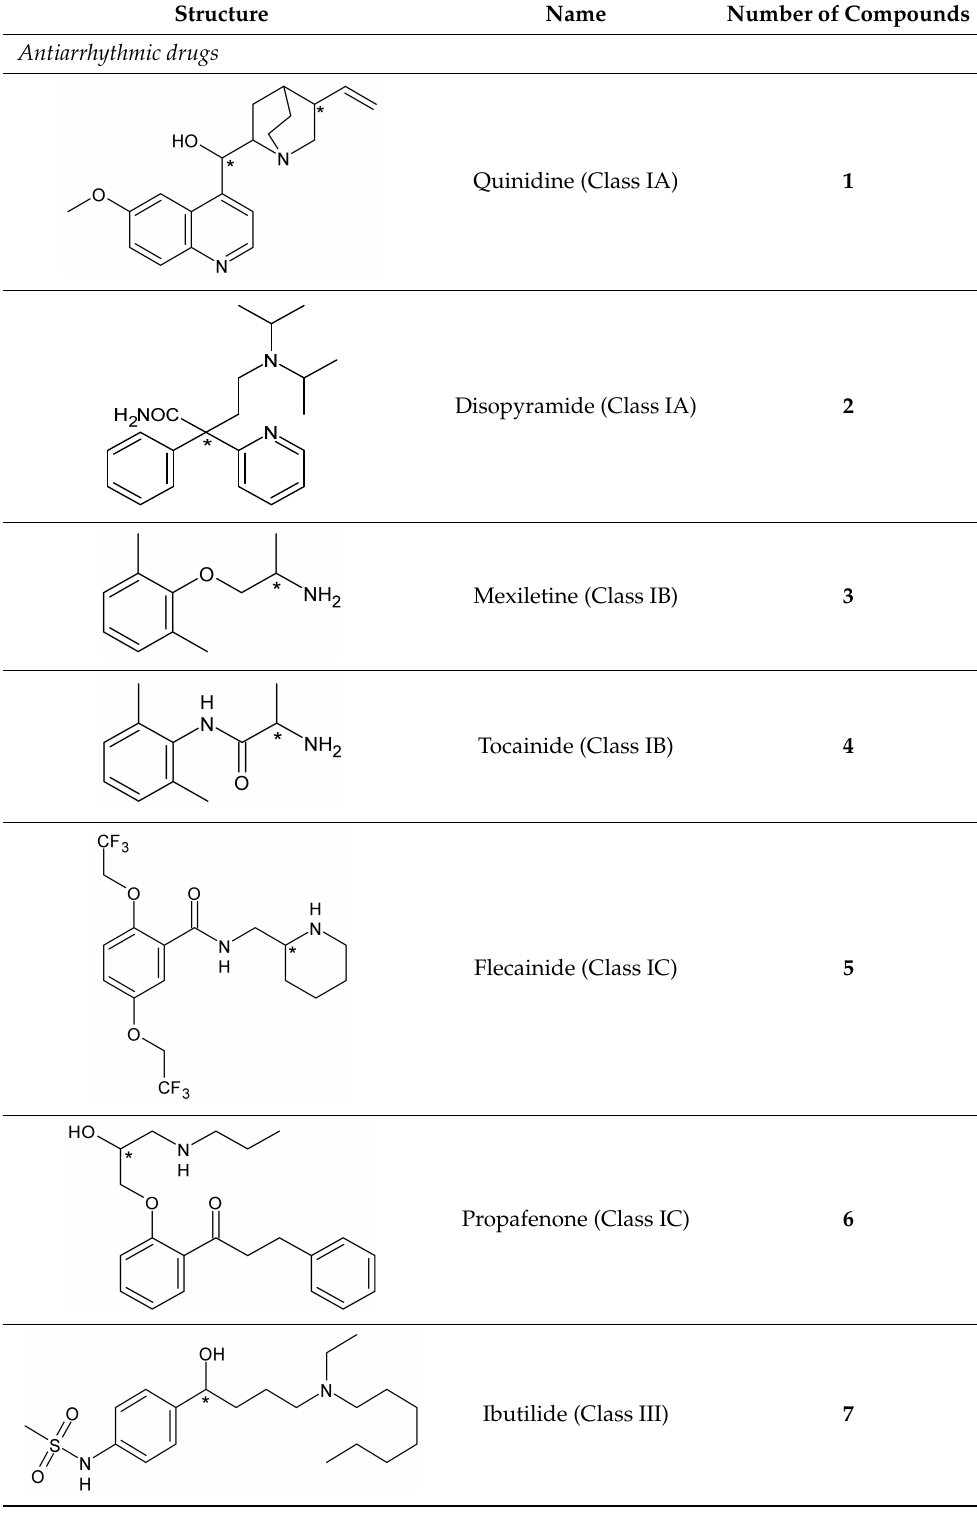
Table 1. Structures of chiral drugs in